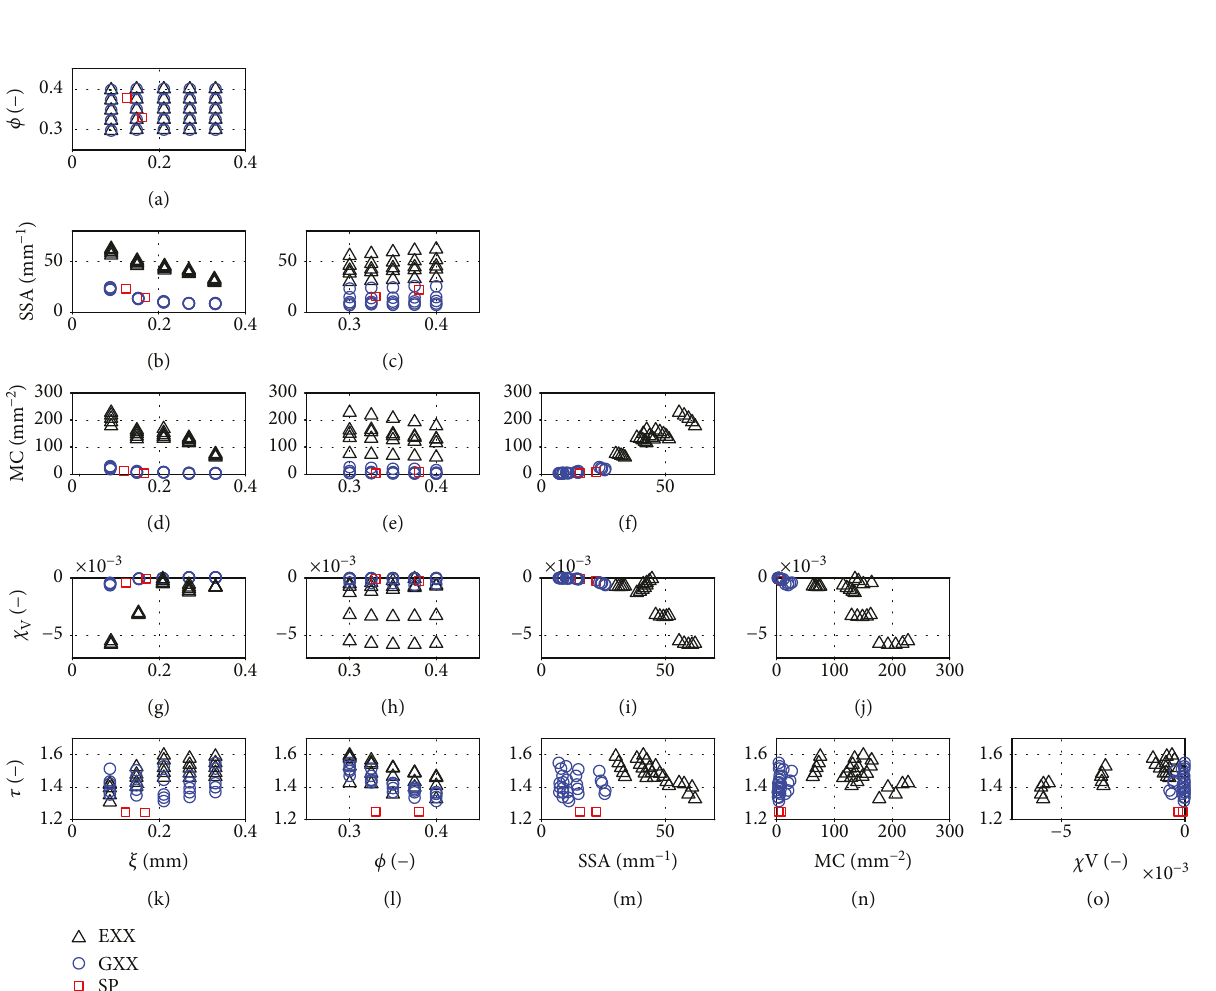
Figure 1: Relationships between values of correlation length ( ξ ), Minkowski functionals — porosity ( φ ), speci fi c surface area (SSA), mean curvature (MC) and Euler number ( χ ) — and tortuosity τ for generated (black triangles and blue circles) and scanned porous media (SP) V as red squares used for numerical simulations. Porous media generated by exponential and Gaussian functions are named EXX and GXX, respectively, where XX refers to the correlation length of each